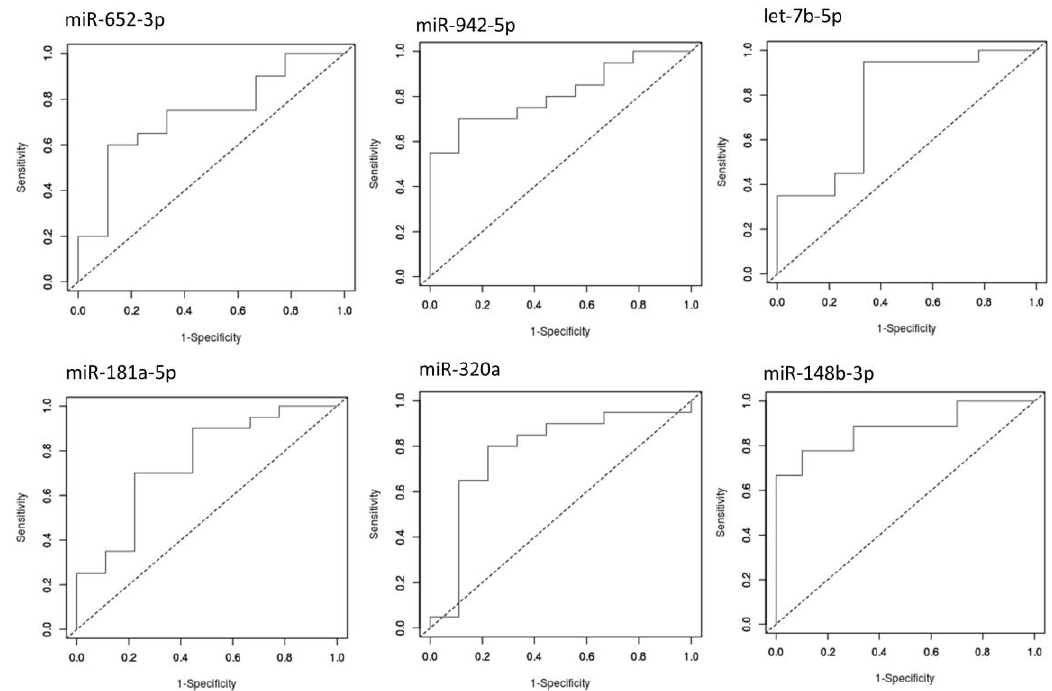
Figure 3. ROC curves generated by using the relative expression data of six DE miRNAs of interest. The diagram is a plot of sensitivity (true-positive rate) versus specificity (false-positive rate). AUC provides an estimate of the miRNA’s ability to discriminate between the compared groups.